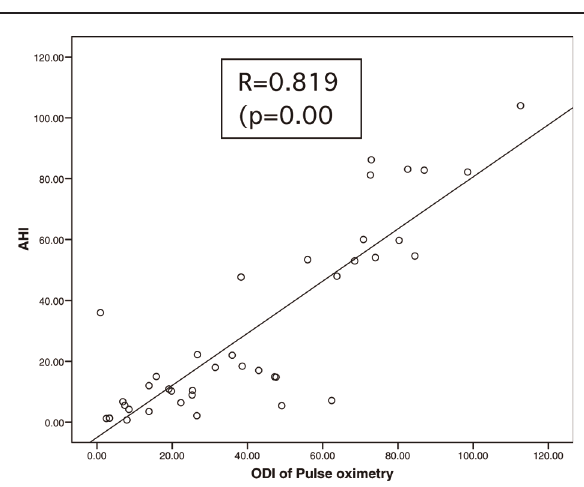
Correlation between apnea hypopnea index (AHI) and oxygen desa- turation index (ODI) of overnight pulse